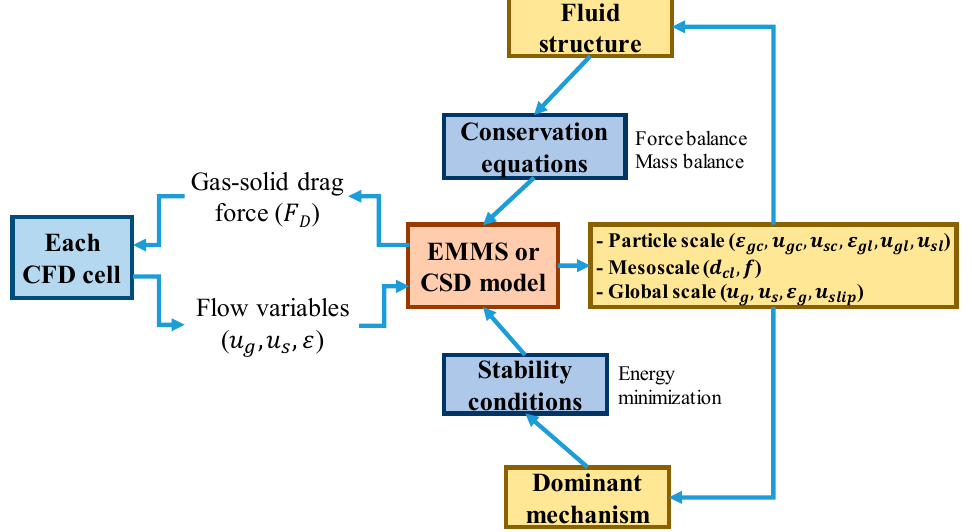
Figure 5. Concurrent coupling strategy of multiscale Eulerian CFD with energy minimization multi- scale (EMMS) or cluster structure-dependent (CSD) in fluidized beds (modified from Li et al. (2018) [87,100]).